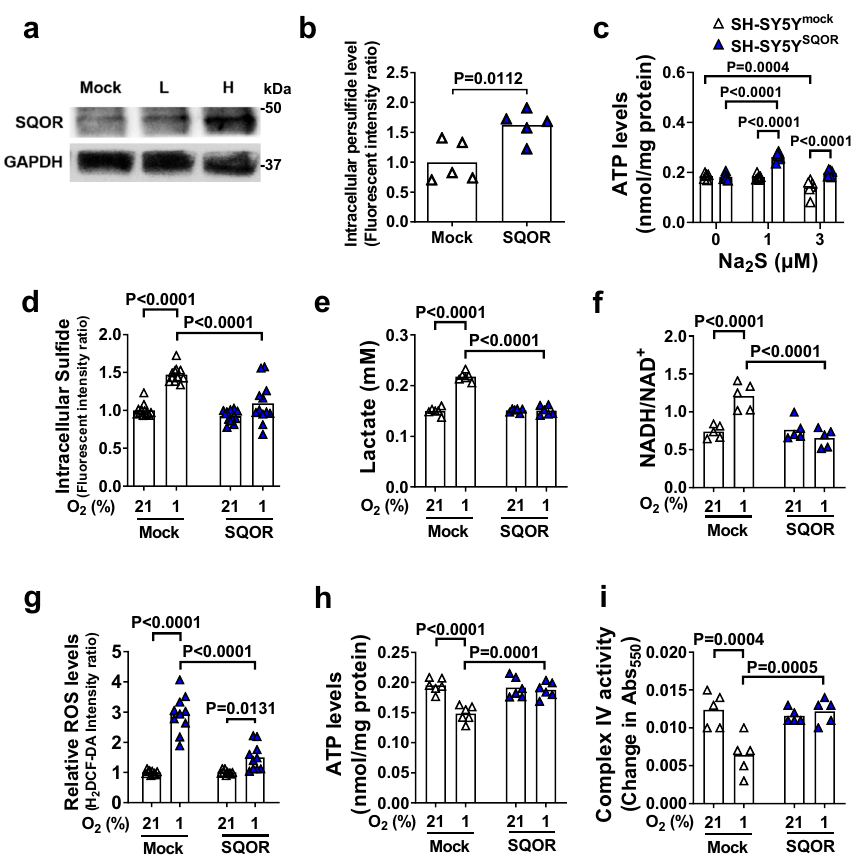
Fig. 5 SQOR improves mitochondrial function in neuronal cells. a Immunoblots of SQOR in SH-SY5Y with mock transfection or SQOR expression (L, H: low and high dose of transfection agent). Representative immunoblots of 2 independent biological replicates are shown. b Effect of SQOR expression on Intracellular persul fi de level in SH-SY5Y cell at 21% O 2 . n = 5 each. c ATP levels in mitochondria isolated from SH-SY5Y cells with or without SQOR expression treated with Na 2 S at 0, 1, or 3 µ M in the medium ( n = 6 each). d Intracellular H 2 S ( n = 12 each), e lactate in cell culture medium ( n = 6 each), f intracellular NADH/NAD + ratio ( n = 5 each), g intracellular ROS ( n = 10 each), h intracellular ATP ( n = 6 each), and i complex IV activity ( n = 5 each) in SH-SY5Y cells with or without SQOR expression in 21% or 1% O 2 . Cells were exposed to hypoxia or normoxia for 3 h starting at 48 h after transfection. Data are presented as mean and individual values. A two-tailed unpaired t -test was performed for b . Two-way ANOVA followed by Sidak ’ s correction for post-hoc comparisons were performed for c – i